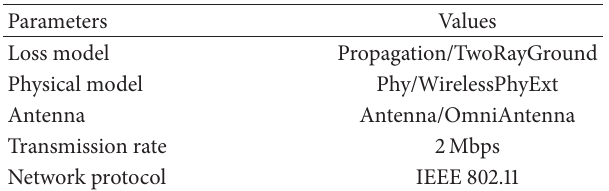
Table 2: The NS2